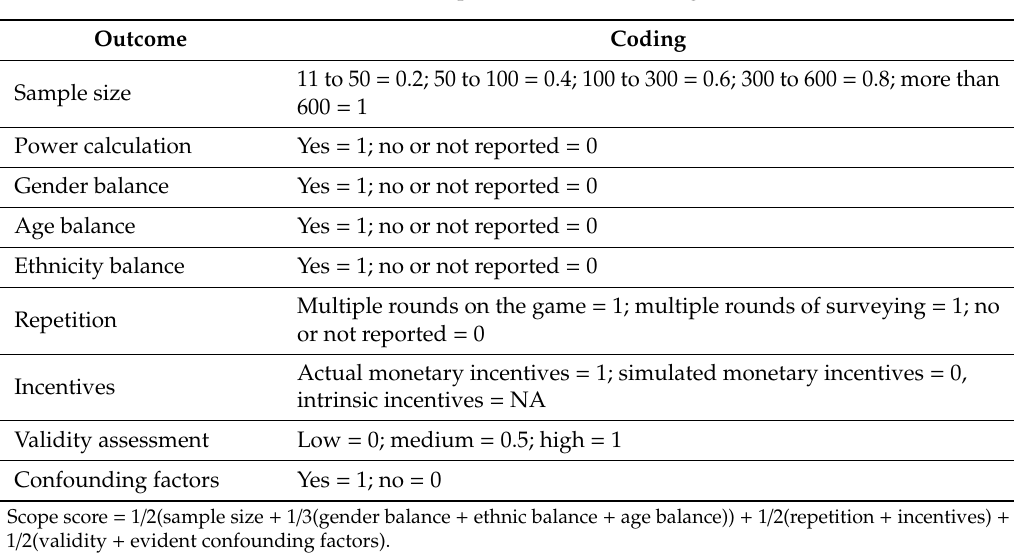
Table A2. Research scope normalization coding scheme.